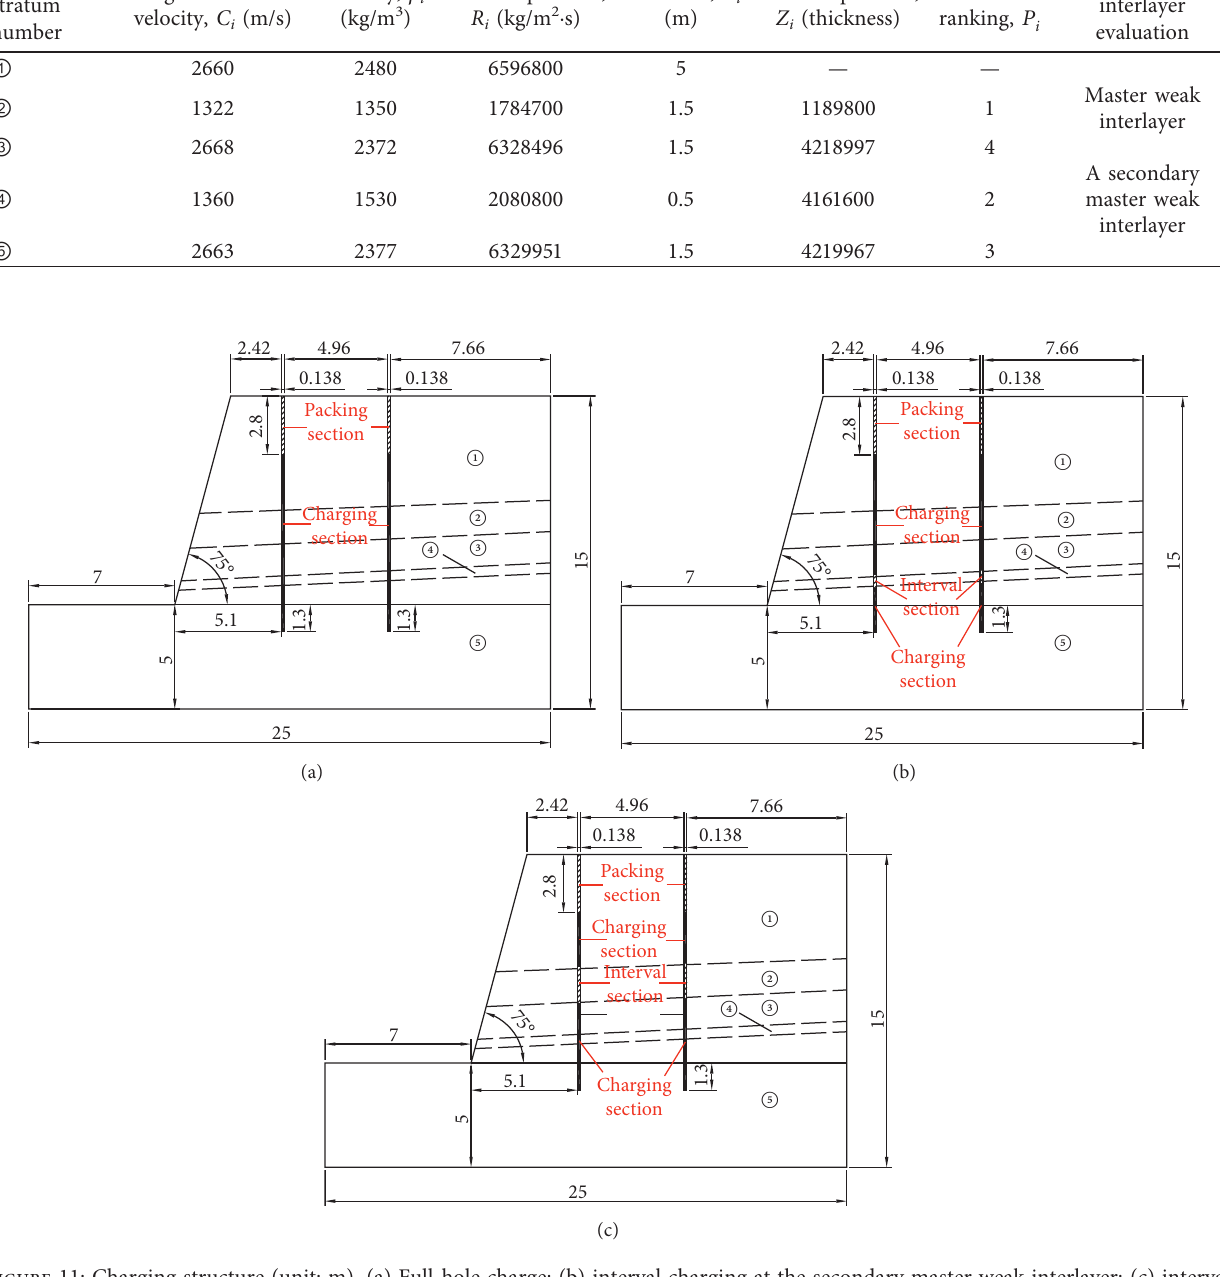
Figure 11: Charging structure (unit: m). (a) Full-hole charge; (b) interval charging at the secondary master weak interlayer; (c) interval charging at the master weak